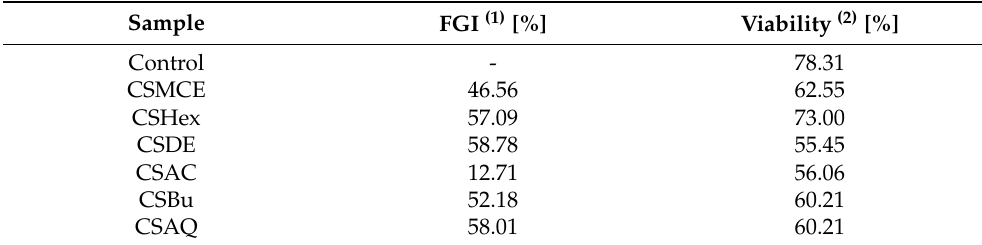
Table 6. Results of antifungal activity against Aspergillus niger of CSECE, CSHex, CSDE, CSAC, CSBu, and CSAQ.